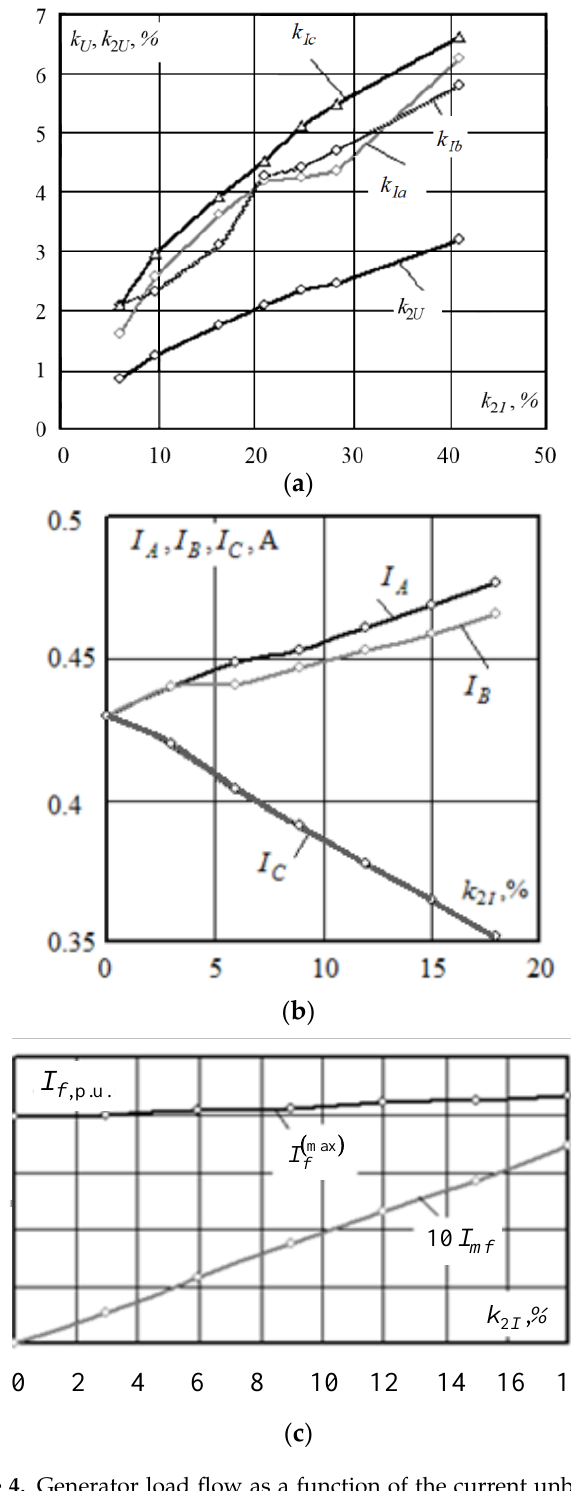
Figure 4. Generator load flow as a function of the current unbalance ratio k 2 I . (( a )— k U = f ( k 2 I ), k 2 U = f ( k 2 I ); ( b )— I = f ( k 2 I ); ( c )— I f = f ( k 2 I